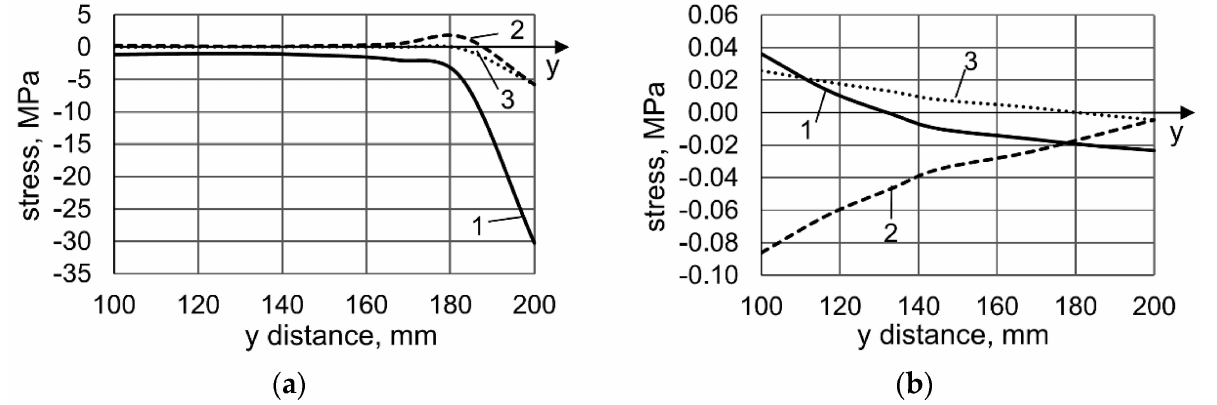
Figure 4. The stress state on the isthmus between the cavity and: ( a ) the upper boundary of the layer; ( b ) the lower boundary of the layer; 1— σ y ; 2— σ x ; 3— σ z